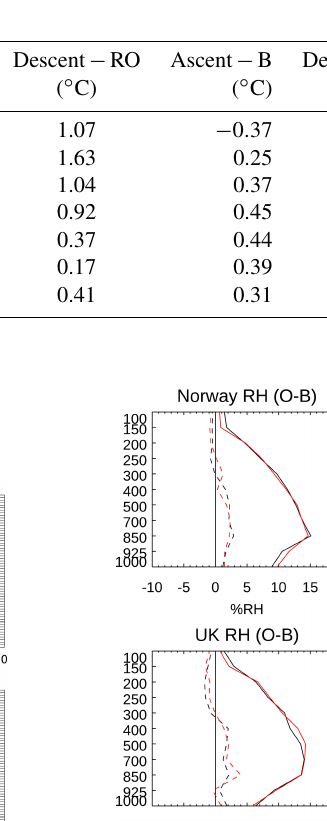
Table 2. Co-locations with radio occultation (RO) retrievals (within 100km and 2h) for all stations at standard levels, with mean temperature differences ( ◦ C). Columns show radiosonde ascent (or descent) minus RO or background (B) values; the comparisons with the background are limited to the profiles co-located with RO.